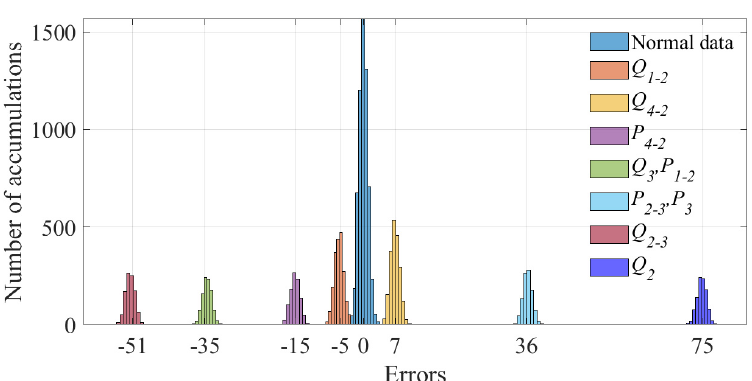
Figure 17. Classification results of the EM algorithm.